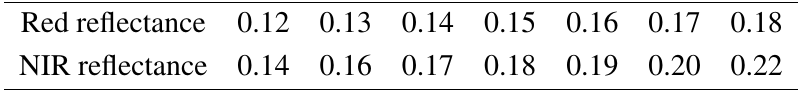
Table 3. Red and NIR reflectances of the assumed non-vegetation endmember spectra in the validation experiment.